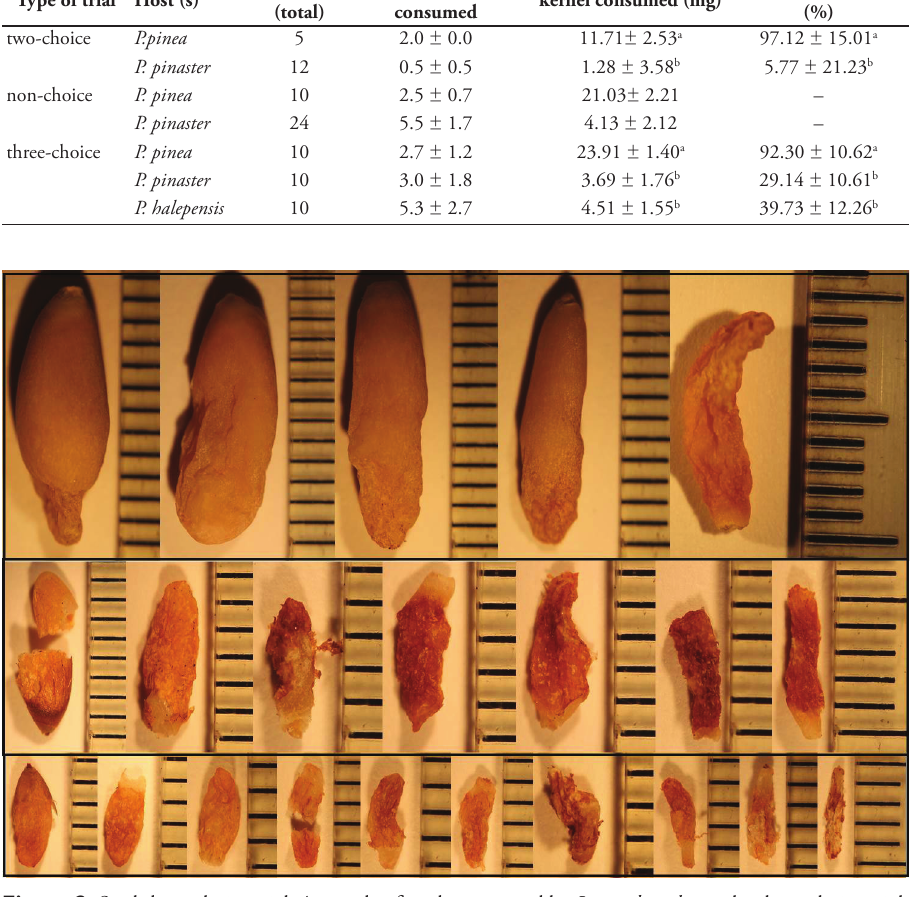
Testing bug preference among seeds of P. pinea , P. pinaster , and P. halepensis Seed consumption was observed on 8 out of the 12 boxes (Figure 2). On these boxes overall, there were no significant differences in the number of seeds consumed be- tween species (Wald Chi 2 =0.011, df=2, p=0.995) (Table 3). The total number of